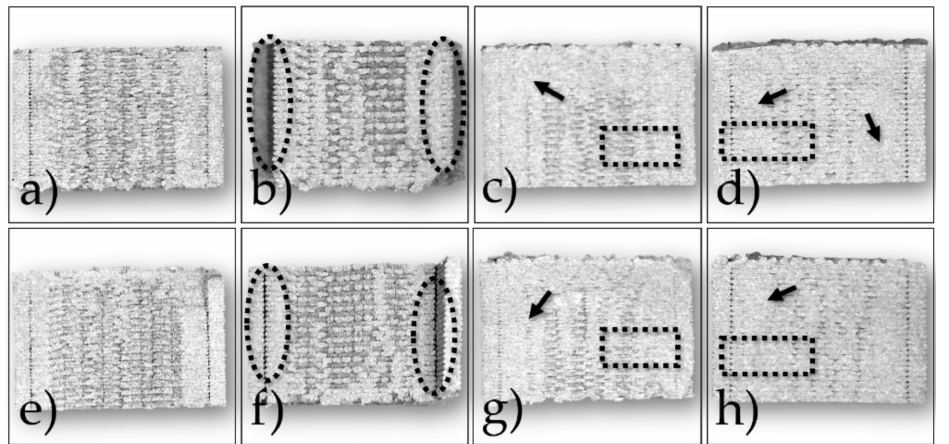
Figure 3. Optical images of green samples cross-sections printed according to the eight configurations in Table 3: ( a ) Nr. 5; ( b ) Nr. 4; ( c ) Nr. 1; ( d ) Nr. 2; ( e ) Nr. 7; ( f ) Nr. 8; ( g ) Nr. 6; ( h ) Nr.